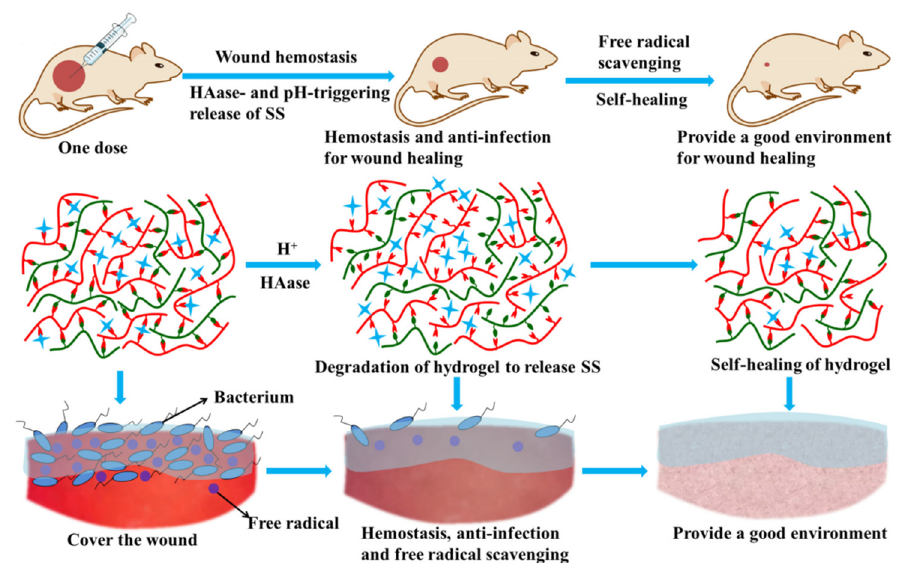
Figure 9. Schematic representation of the pH- and HAase-sensitive A-HA/HA-ADH/SS hydrogel functions, regarding hemostasis, antimicrobial action, free radical scavenging, and self-healing properties. Adapted with permission from [51].